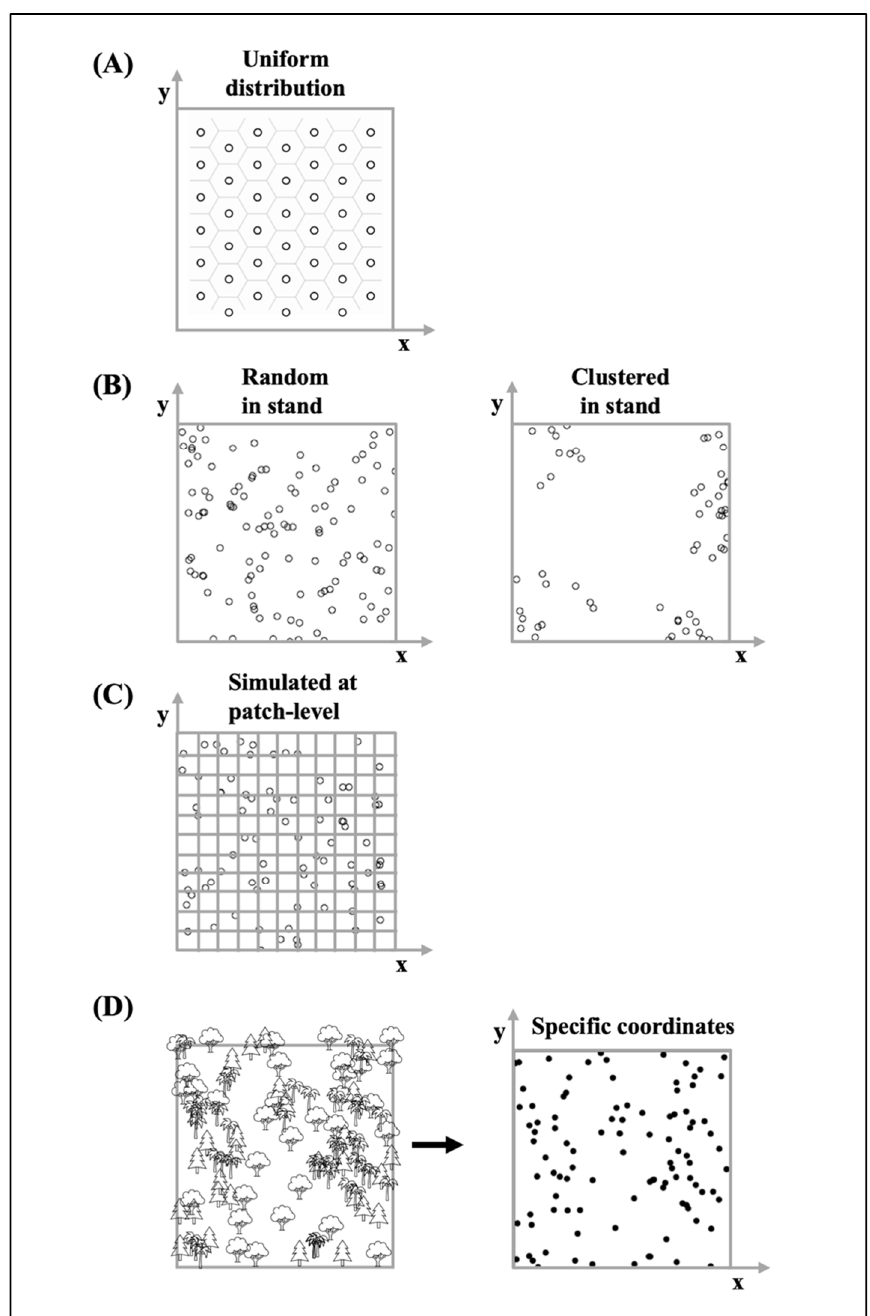
Figure 3. Representation, or implied representation, of tree distributions in different model types. Distance-independent models do not specify locations in space; they implicitly assume all trees have equal space, which would imply an equidistant lattice if represented spatially ( A ). Distance-dependent, non-spatially explicit models assume different statistical distributions of distances between individual trees across a stand. Examples of distributions, realized spatially for illustrative purposes, include random and clustered ( B ). In distance-dependent spatially explicit models, the locations of individual trees are typically simulated within a forest gap (represented by grid cells) ( C ) or are mapped as (x, y) coordinates within a stand ( D ) [64].